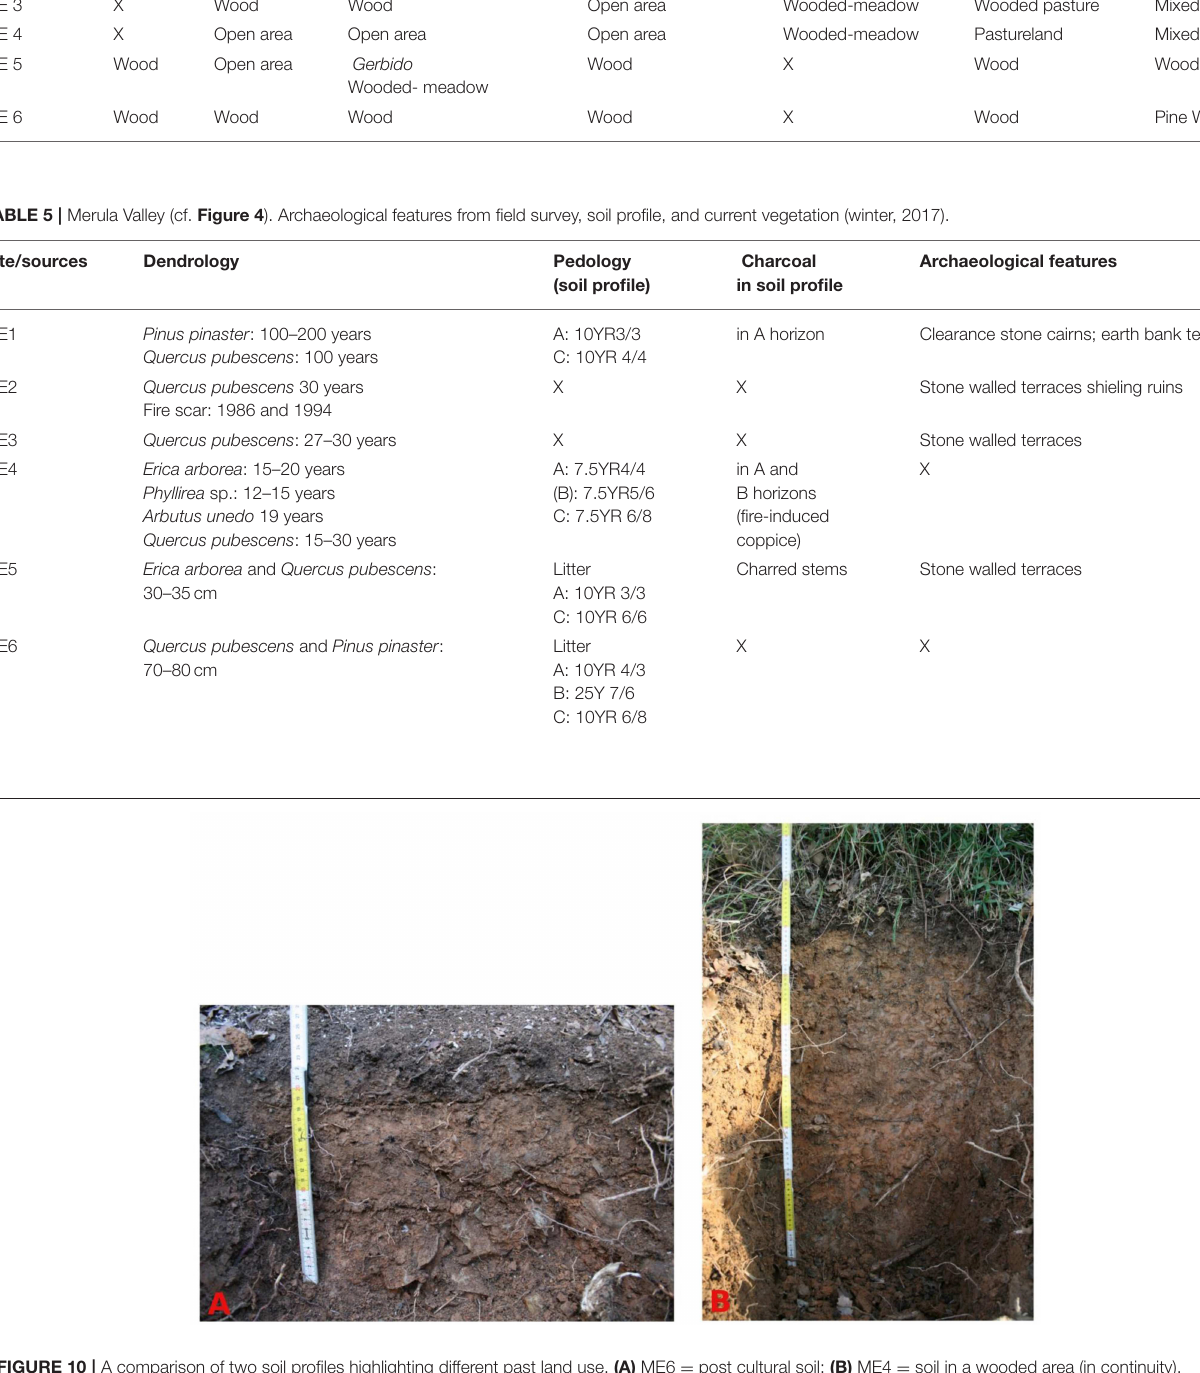
FIGURE 10 | A comparison of two soil profiles highlighting different past land use. (A) ME6 = post cultural soil; (B) ME4 = soil in a wooded area (in continuity).